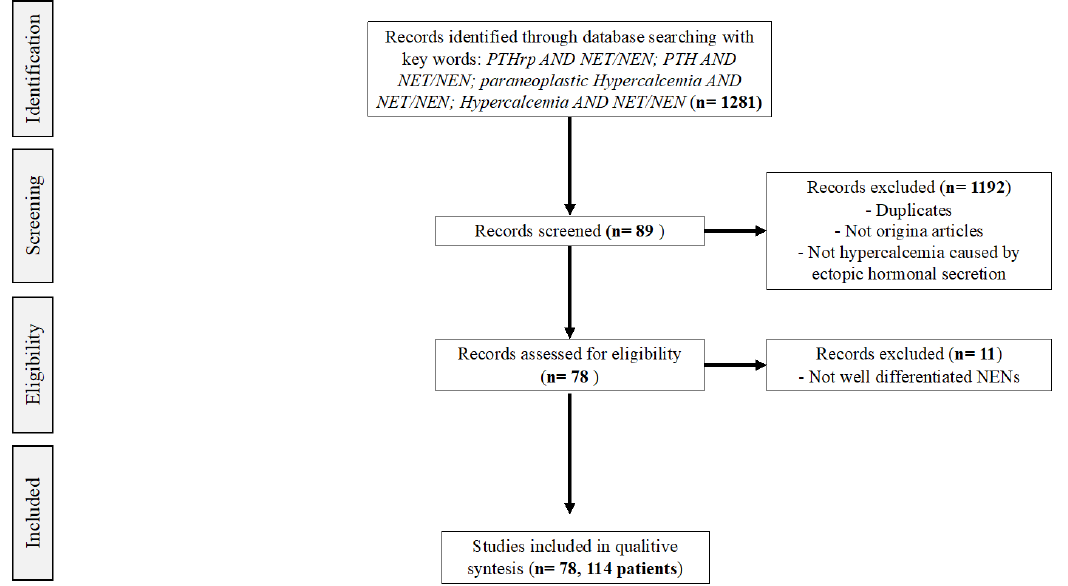
Figure 1. Flowchart of the literature search for the systematic review study. From: Liberati A, Altman DG, Tetzlaff J, Mulrow C, et al. (2009) The PRISMA Statement for Reporting Systematic Reviews and Meta-Analyses of Studies That Evaluate Health Care Interventions: Explanation and Elaboration. PLoS Med 6(7): e1000100. doi:10.1371/journal.pmed.1000100